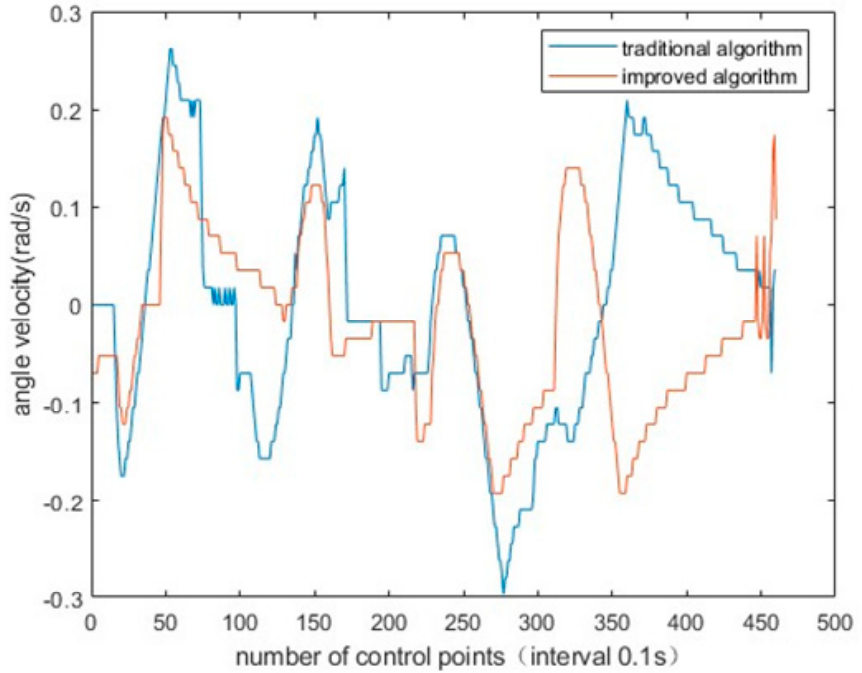
Figure 12. Improved algorithm and traditional algorithm for AGV angle velocity.